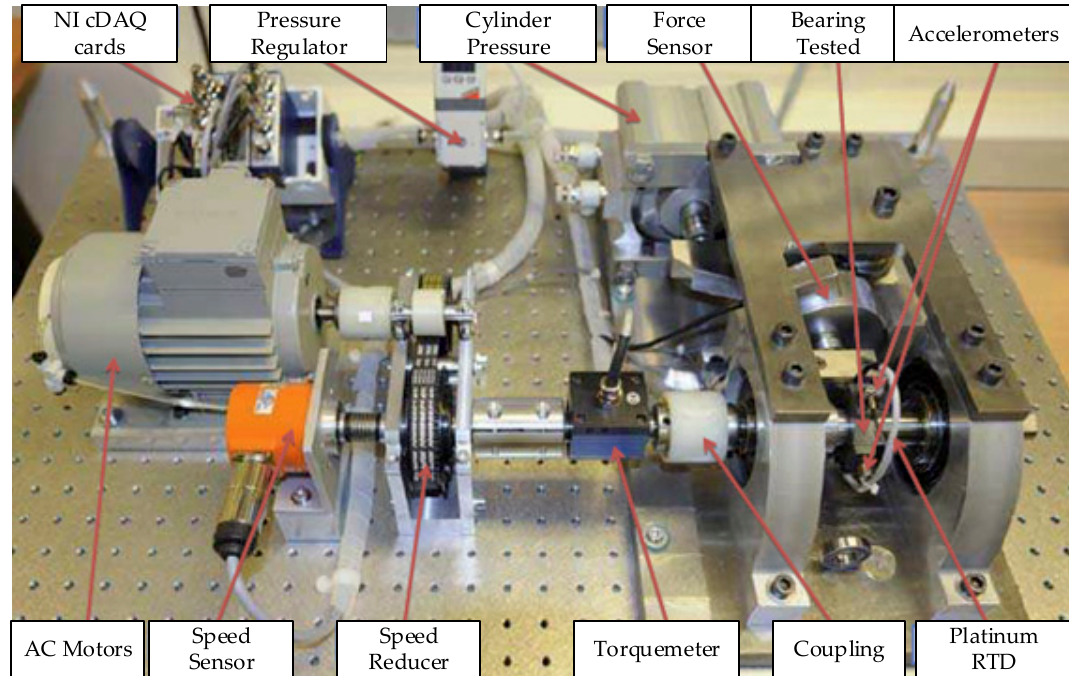
Figure 13. Overview of PRONOSTIA [34].